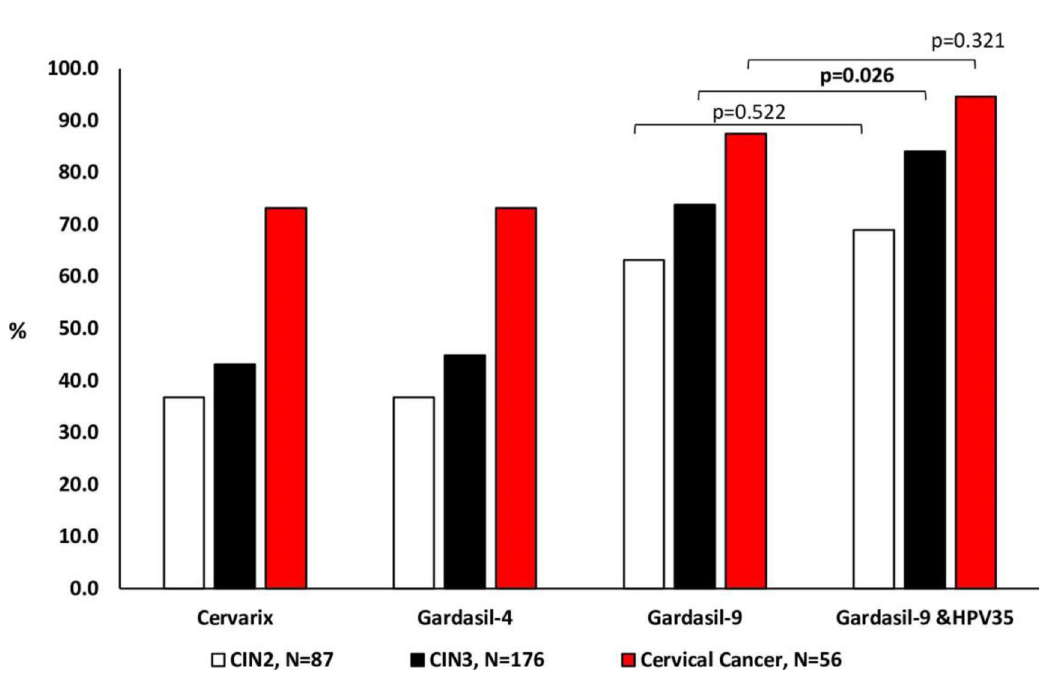
Fig 5. Prevalence of Human papillomavirus (HPV) types targeted by current commercial HPV vaccines among women according to cervical disease status (Cervarix vaccine targets HPV–16/18; Gardasil–4 vaccine targets HPV–6/11/16/18 and Gardasil–9 vaccine targets HPV–6/11/16/18/31/33/45/52/58).